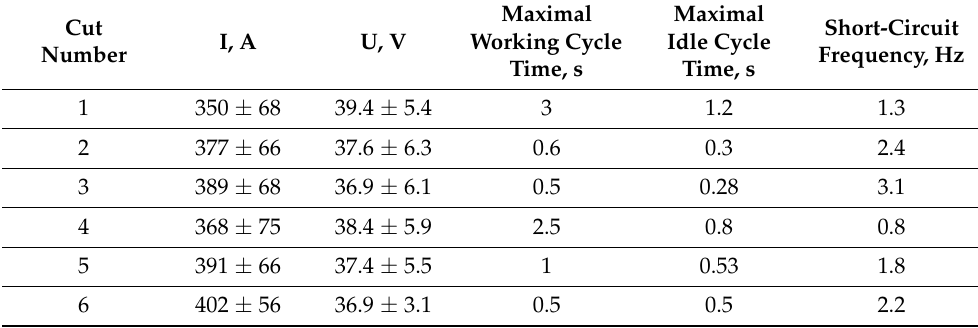
Table 5. Parameters of underwater wet cutting of AISI 304L steel with PPR-APL1-1 wire.